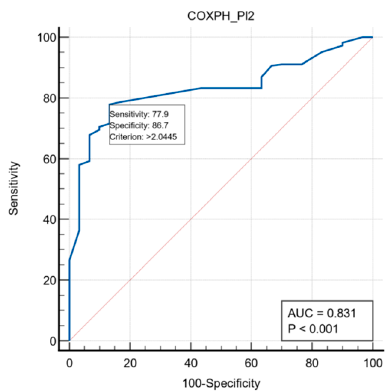
Figure 1. ROC curve of the multivariate Cox regression model.